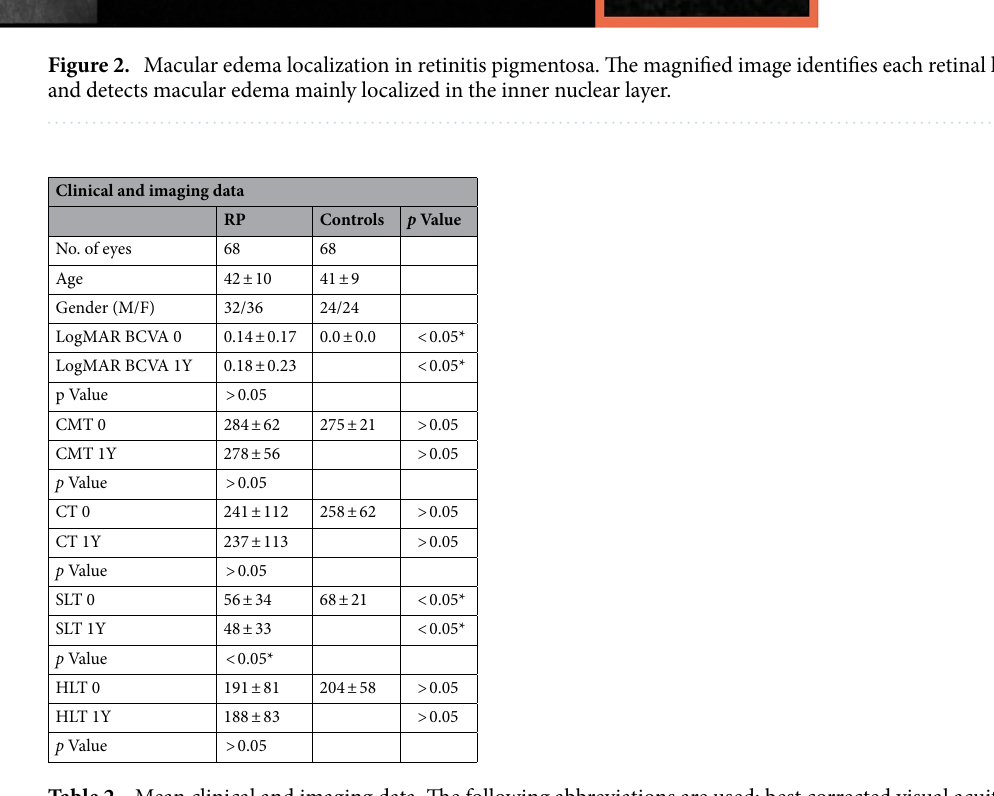
Table 2. Mean clinical and imaging data. The following abbreviations are used: best corrected visual acuity (BCVA), central macular thickness (CMT), choroidal thickness (CT), Sattler layer thickness (SLT), Haller layer thickness (HLT). Statistically significant values, expressed for simplicity as p < 0.05, are marked by asterisks